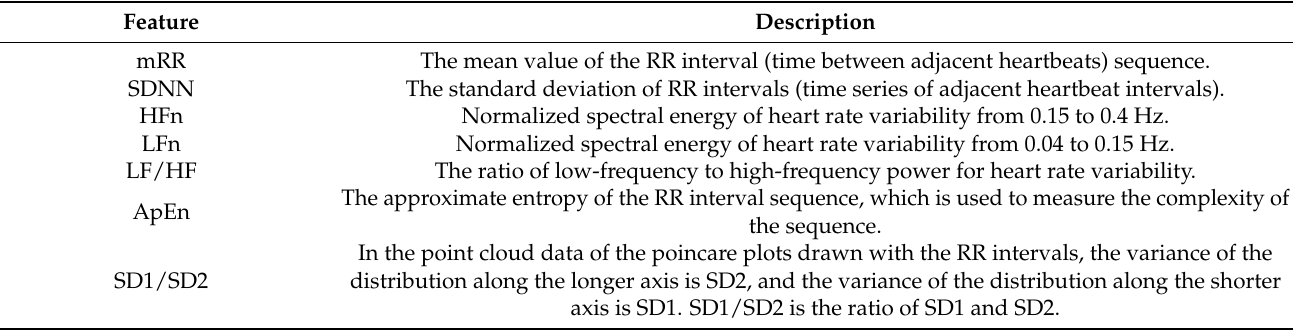
Table 1. HRV features and their descriptions in the